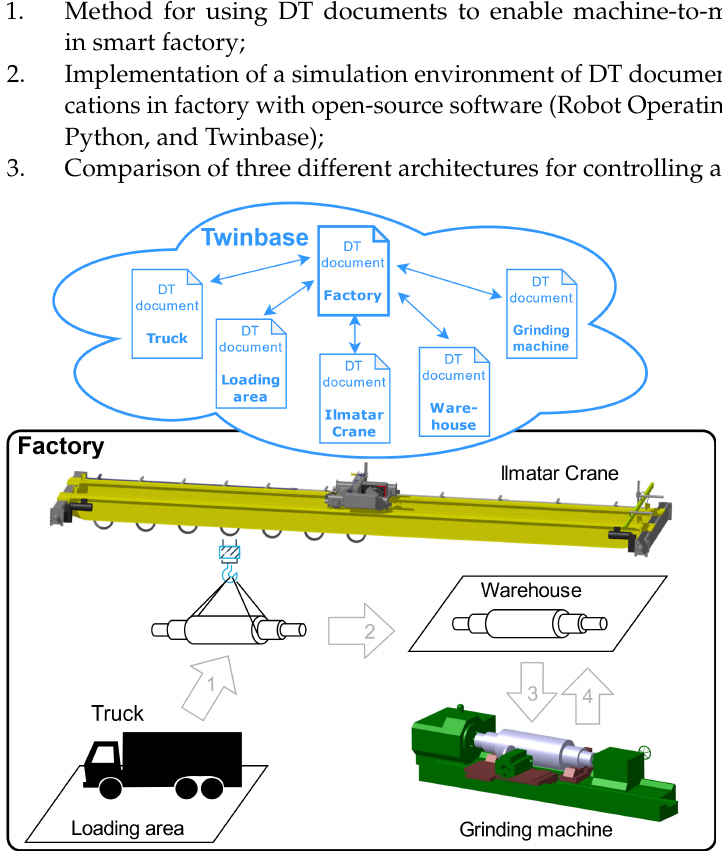
Figure 1. Overview of the factory operation and its DT documents. The gray arrows 1–4 show the operating logic of the factory, i.e., unloading rolls, storing them in a warehouse, and maintaining them on a grinding machine. Each object and the factory itself have corresponding DT documents that are stored in Twinbase. The DT documents have parent–child relationships to enable the discovery of other machines located in the